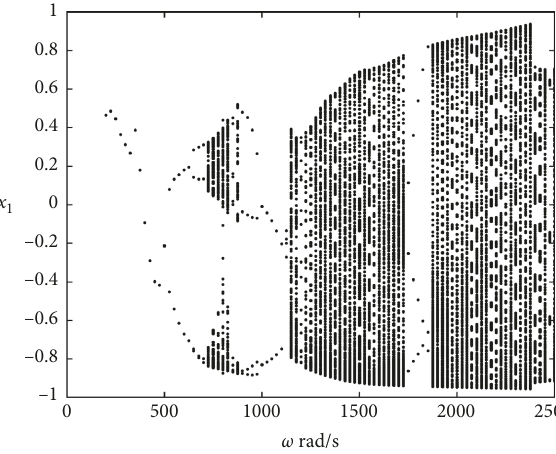
Figure 2: Bifurcation diagram of the rotor system in the x